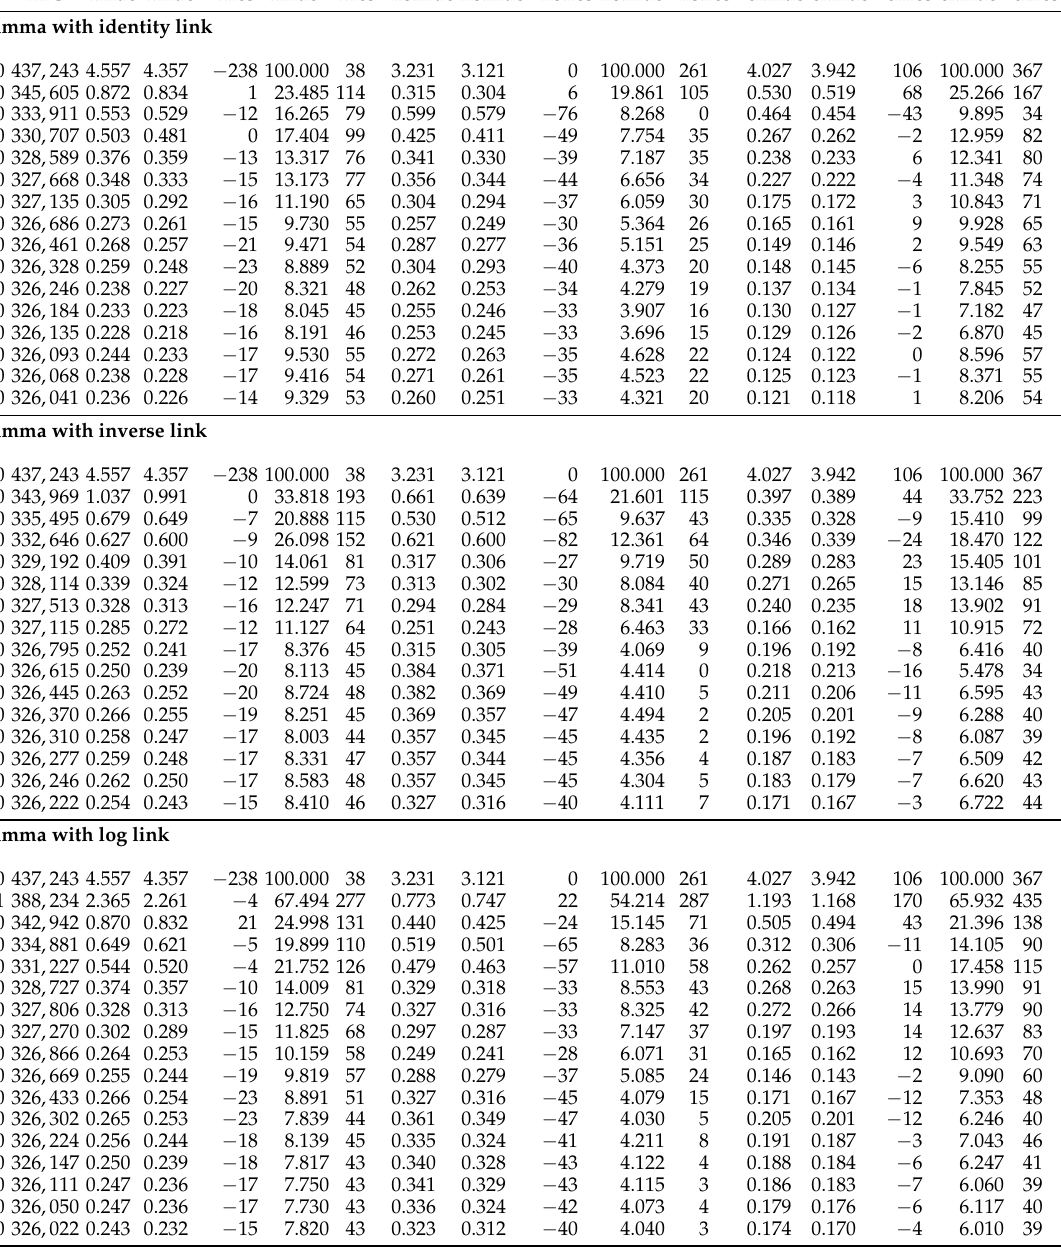
Table A9. AIC scores and out-of-sample validation figures of the gamma GLMs of BEL with identity, inverse and log link functions under 150–443 after each tenth